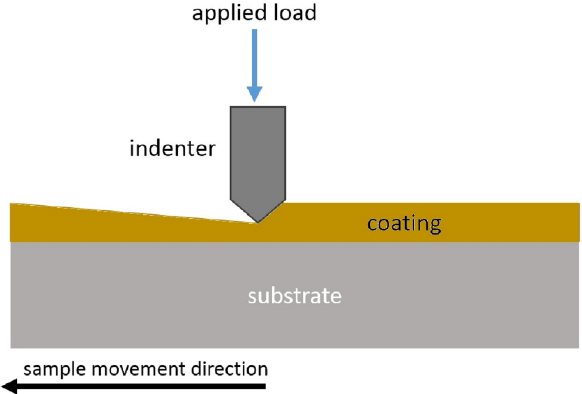
Figure 7: Schematic representation of the scratch test (based on [48]). A Rockwell C indenter is pulled over the surface of the sample with the increasing normal